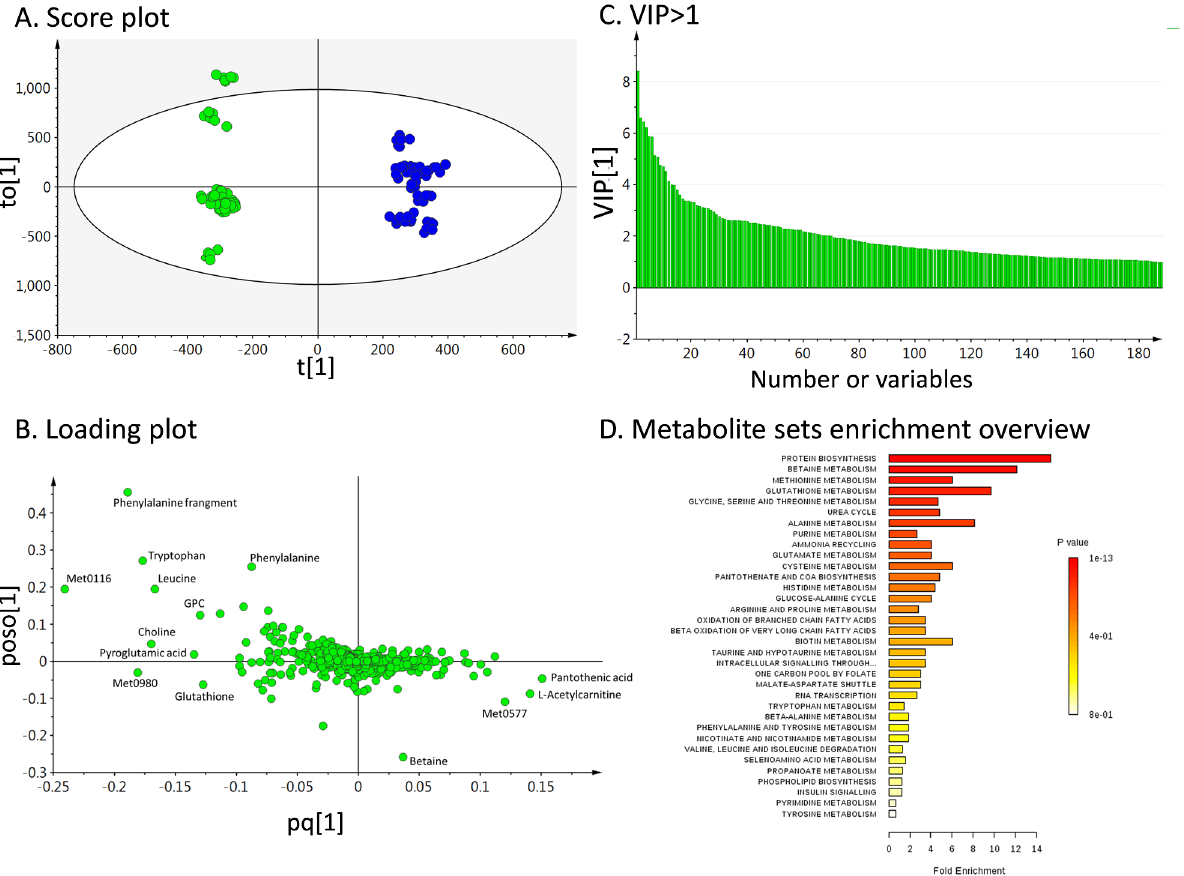
Fig 1. Metabolomic data in miR-122adeficient mice. (A) Orthogonal partial least-squares discriminant analysis(OPLS-DA) score plot of metaboliteprofiles derived from 10 miR-122adeficientmice (green)and the 10 control mice (blue) with correspondingloadingplot. The ellipseshown in the model representsthe HotellingT2 with 95% confidence. Each data point represents one mouse liver sample, and the distancebetweenpoints in the plot indicates the similarity between samples. (B) OPLS-DA loadingplot of liver metaboliteprofiles, each point in representsone feature (or metabolite). (C) Plot of variablesimportance for the projection (VIP) summarizes the importanceof the variables(Fig 1A and 1B). The VIP ranking priority was accordingto the VIP values, and metabolites with VIP > 1 are shown. (D) The 35 metabolites were used for metaboliteset enrichment analysis(MSEA). These metabolitesets are ranked accordingto the Holm P value with hatched lines shown. Liver tissue samples were extracted by the Folch method, and the aqueous(upper)phases were analyzedusing LC-TOFMS in the electrospray positive ion mode. Each sample analysisconsists of six replicates. A web-basedtool (www.metaboanalyst. ca) for metaboliteset enrichment analysiswas used for the analysis. Detail metabolomics differenceswere revealedby OPLS-DA model (R 2 X = 0.612, Q2 = 0.984). The axes, t[1], to[1], pq[1], and poso[1]depict the predictivecomponent,the first orthogonal component,the predictivecomponentloadings,and the first orthogonalloadings, respectively,of the OPLS-DA